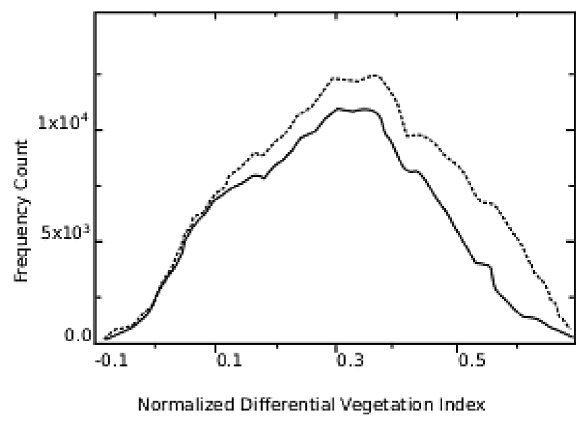
Figure 9. Distribution of NDVI values in the areas covered by the two modified event inventories. Dotted line shows the modified photo-interpreted (PI) inventory. Continuous line shows the mod- ified semi-automatic (SA)